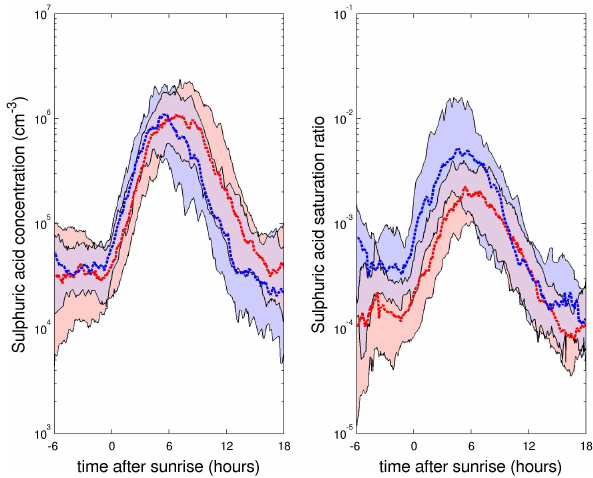
Fig. 7. The number of water molecules attached to sulfuric acid as a function of the temperature for overcharged (red dots) and un- dercharged (blue dots) days. The full lines represent the median of all over- (red) and undercharged (blue) days, the short and thick dashed lines are the 25th and 75th percentiles, and the long thin dashed lines are the 10th and 90th percentiles with the same color